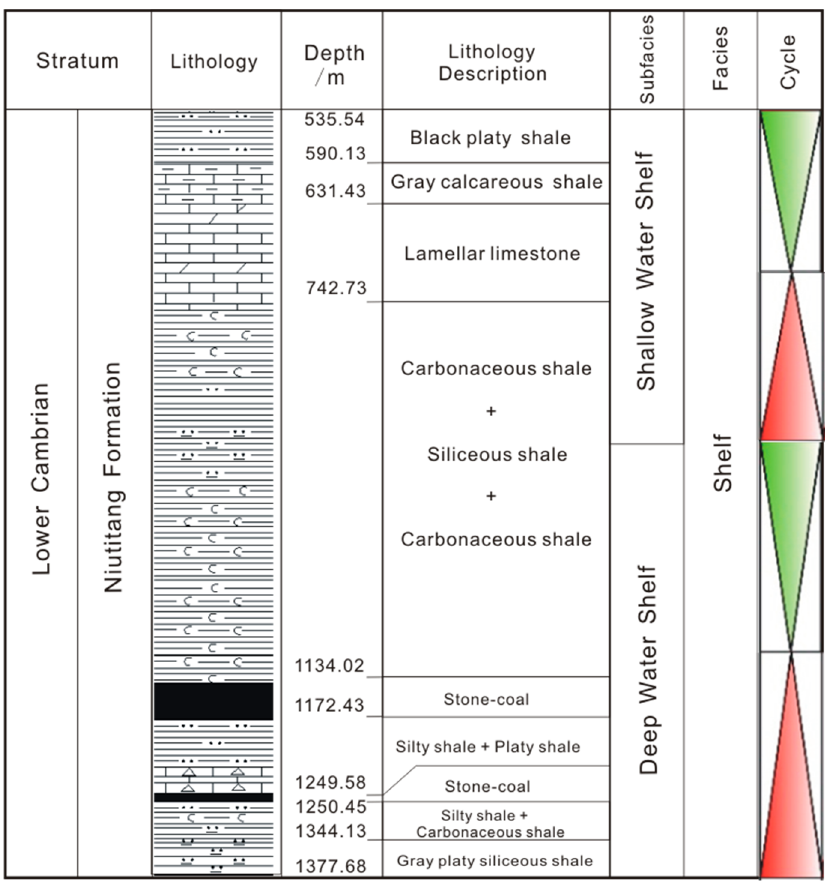
Figure 2. Niutitang Formation sedimentary and stratigraphic section at well CY-1.